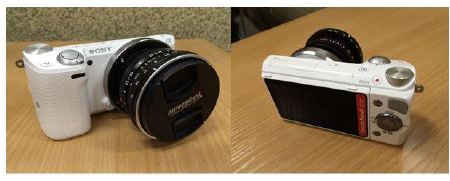
Figure 1. Sony NEX 5T camera with NIR matrix